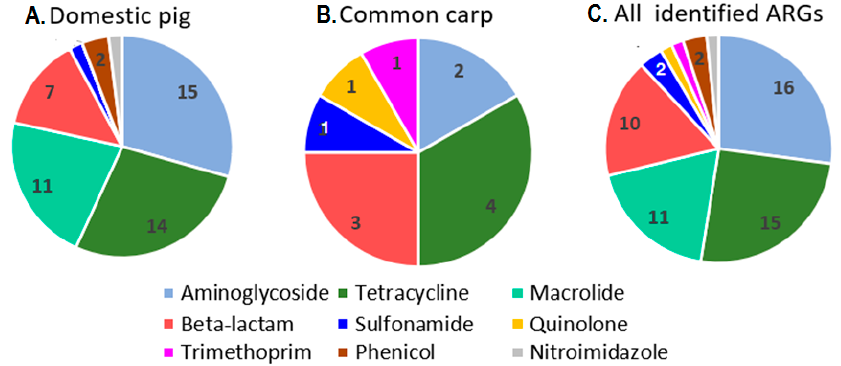
Figure 2. The number of ARG types assigned to different antibiotic classes. ( A ) Domestic pig intestinal samples, ( B ) common carp intestine, and ( C ) all samples analyzed. Pie chart sections without a number contain one ARG type. ResFinder antibiotic classes were applied according to Munk et al. (2018) and Van Gompel et al. (2019) [30,31]. Table 1. Summary of the ARG types detected in domestic pig and common carp intestinal samples Of the 51 identified ARG types, 44 genes (86.2%) were detected in feces, 38 genes from Hungary a . (74.5%) in the small intestine, 12 genes (23.5%) solely in feces, and 6 genes (11.7%) solely in the small intestine (Table 2). Their coverages ranged from 60% to 100% in accordance with the applied ABRicate parameter settings, where 100% query coverage was obtained for 42 ARG types from swine. The percentage identity with the ResFinder reference sequences was ≥ 95% for all ARGs reported in this work, making the analysis more stringent than the >90% identity threshold recommended by Lal Gupta et al. (2020) and Doyle et al. (2020) [26,32]. Identity cutoffs > 90% were suggested to increase the probability of targeting genes that are actually functional ARGs